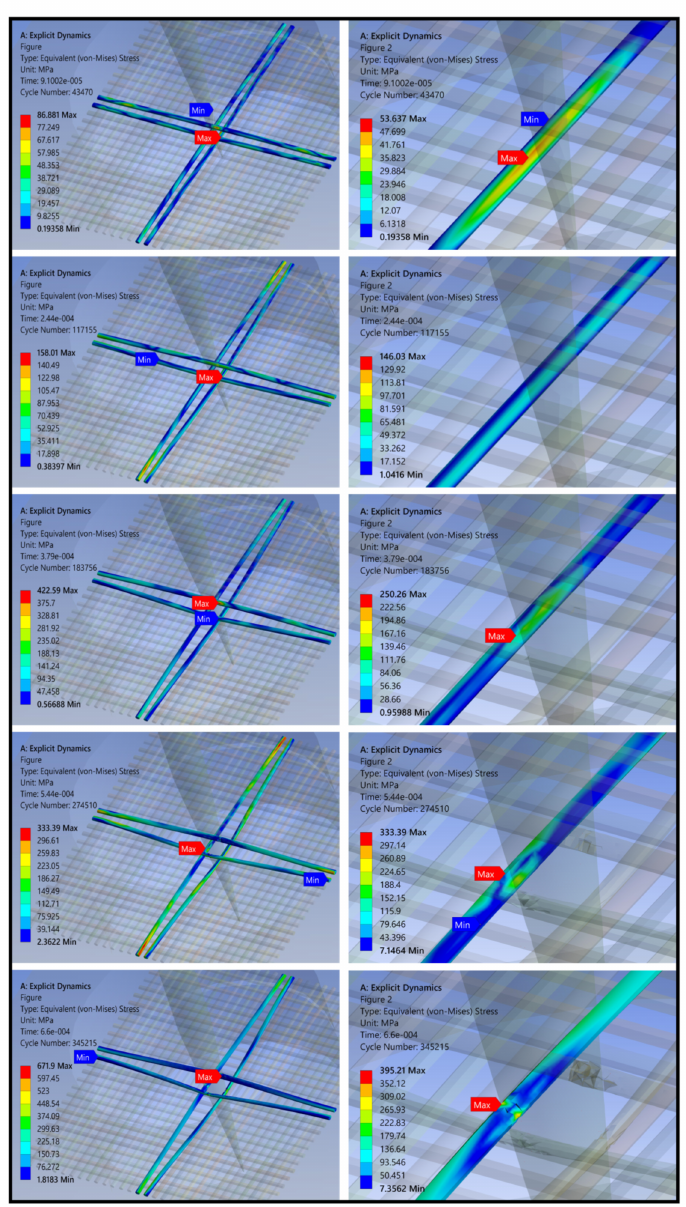
Figure 17. Damage morphologies obtained from the finite element method (FEM) results (stress diagram of yarn